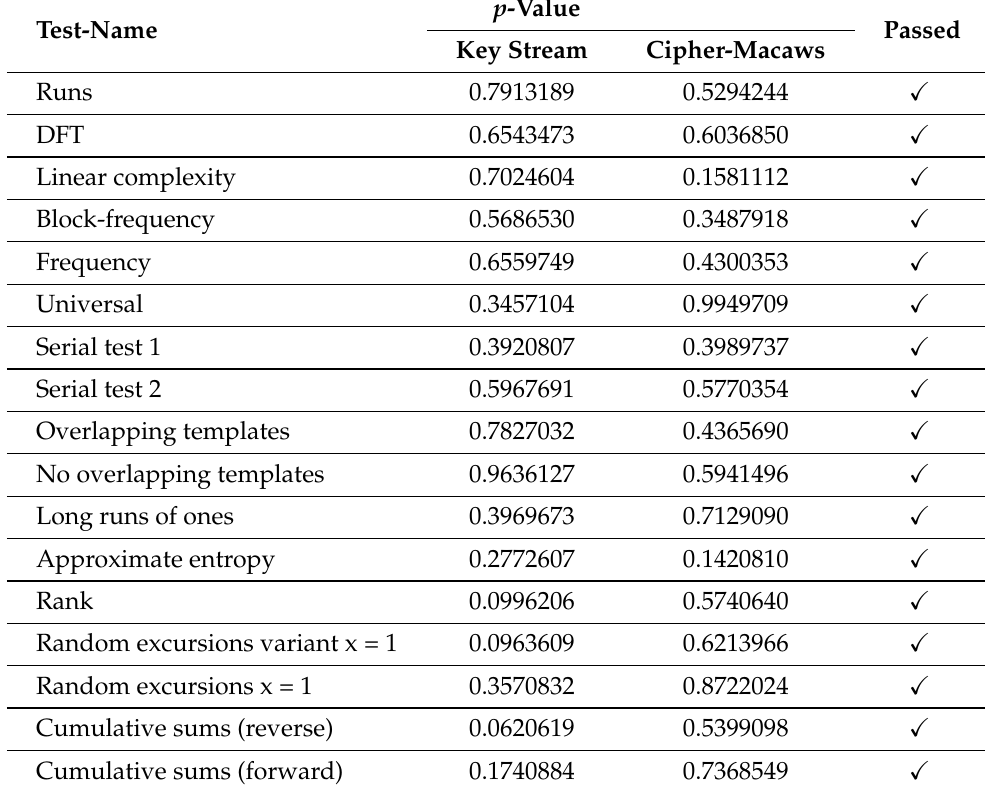
Table 2. Outcomes of randomness